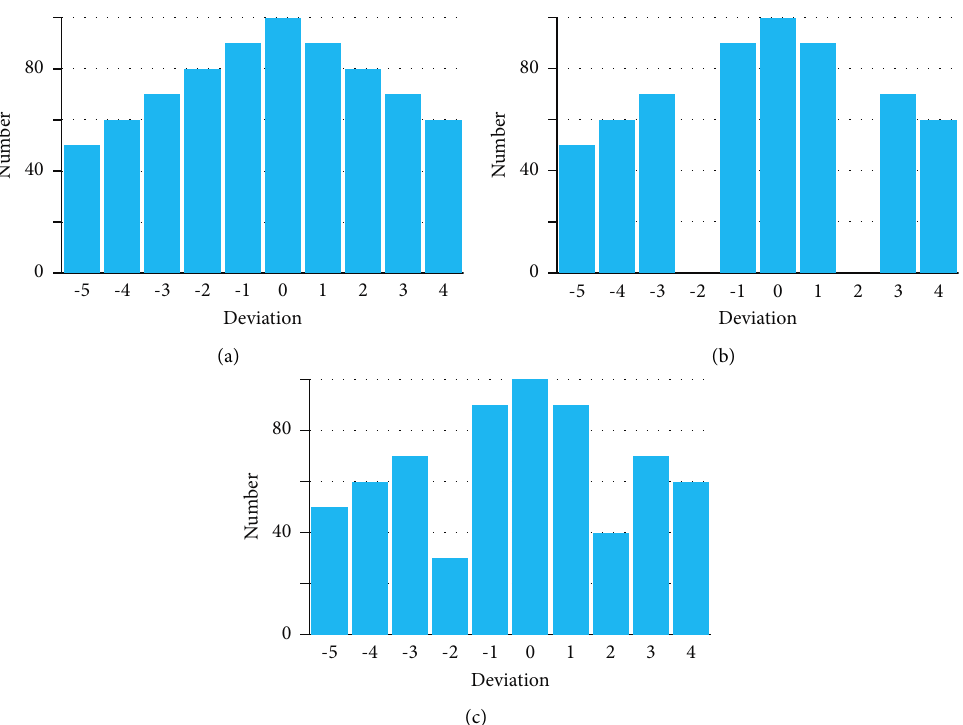
Figure 7: The translation process of the prediction error histogram: (a) histogram of the prediction error; (b) histogram of the prediction error after translation; (c) prediction error histogram with additional